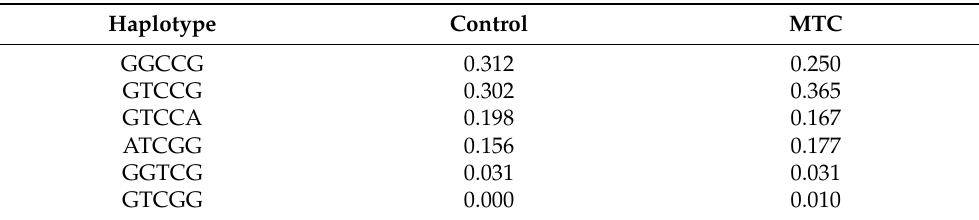
Table 2. Fractions of haplotypes identified in the study population. Order of variants in the haplo-